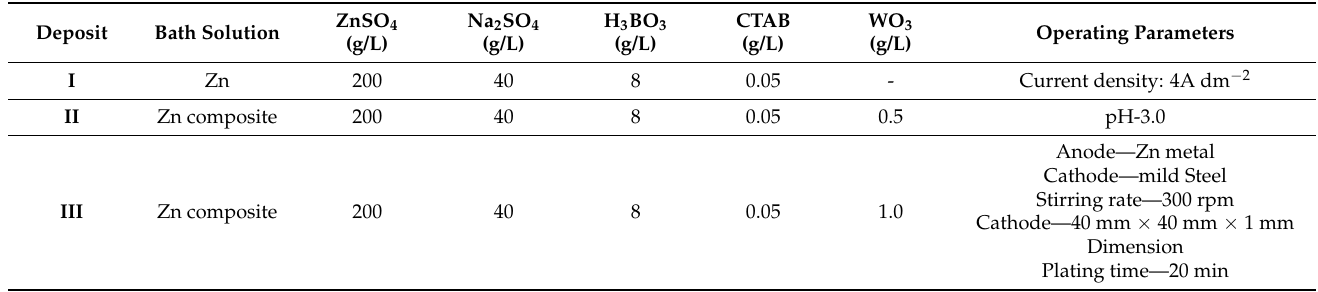
Figure 1. Experimental setup for composite electrodeposition. Table 1. Optimized constituents of Zn bath solution and its operating